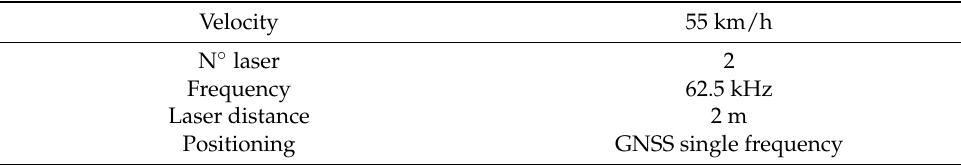
Table 2. Main profilometer data parameters.